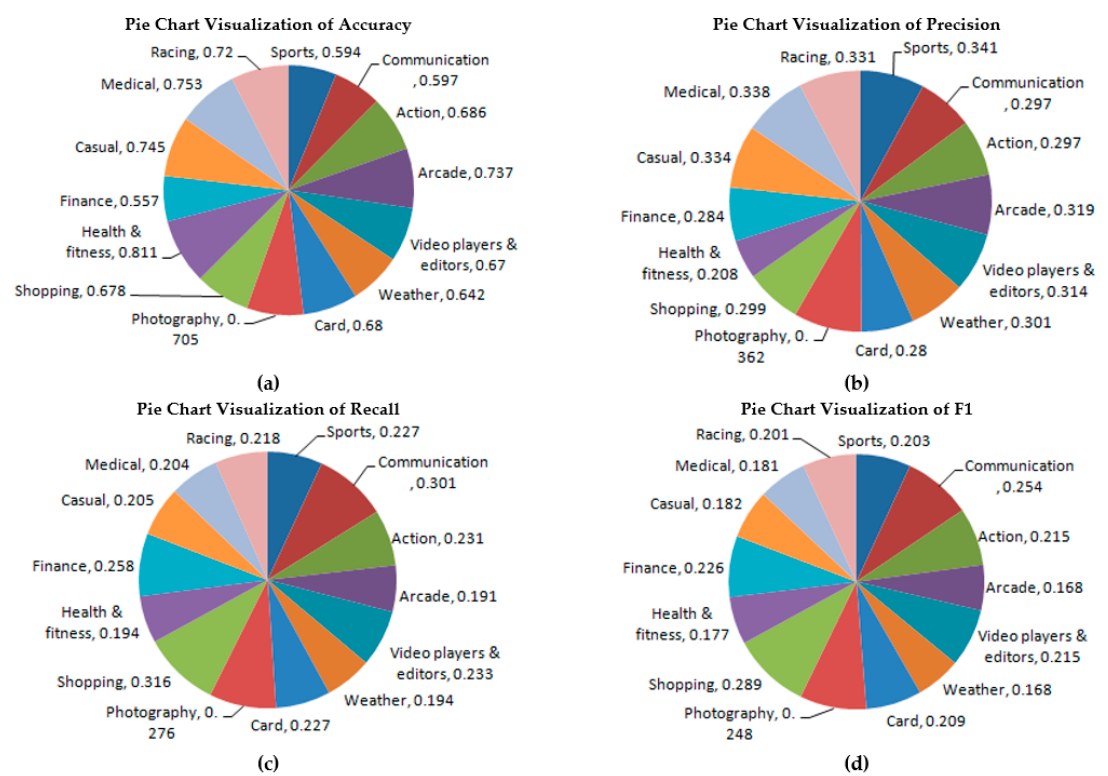
Figure 7. Pie chart visualization of different machine-learning algorithm comparison of TF/IDF-based data after preprocessing.